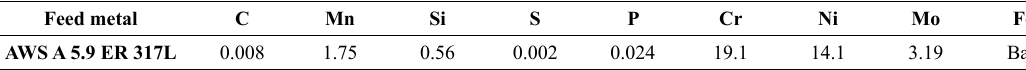
Table 2. Chemical composition of the rod GTAW (wt%). (Fe) balance. Feed metal